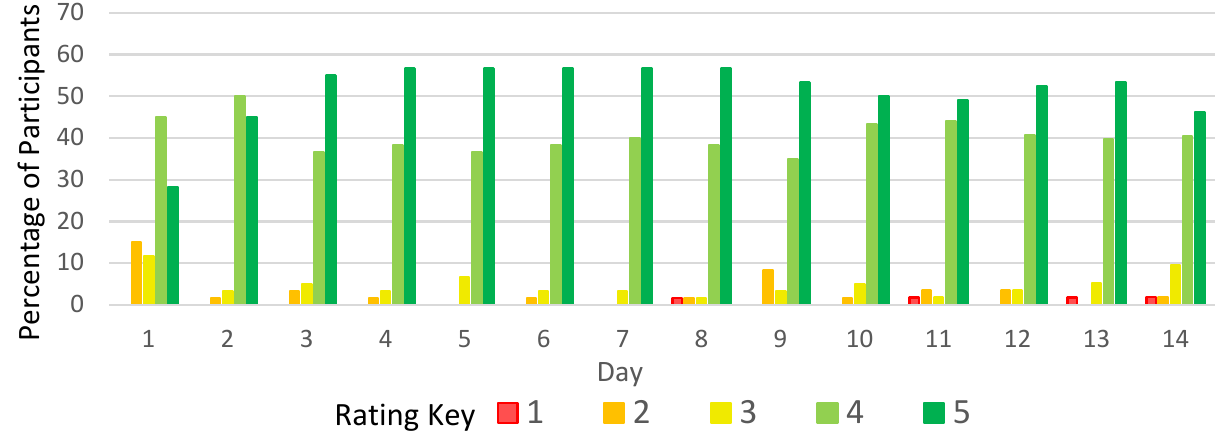
Scheme 10. Parent survey results for: Setting the Dose.